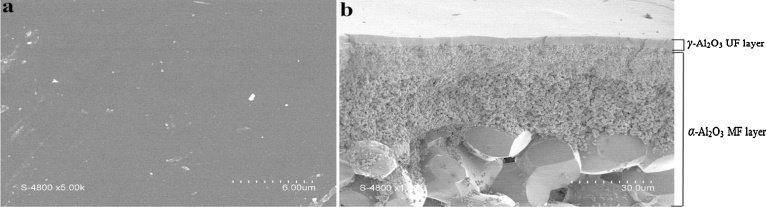
SEM of γ-Al2O3 membrane: top surface (a) and cross-section (b).